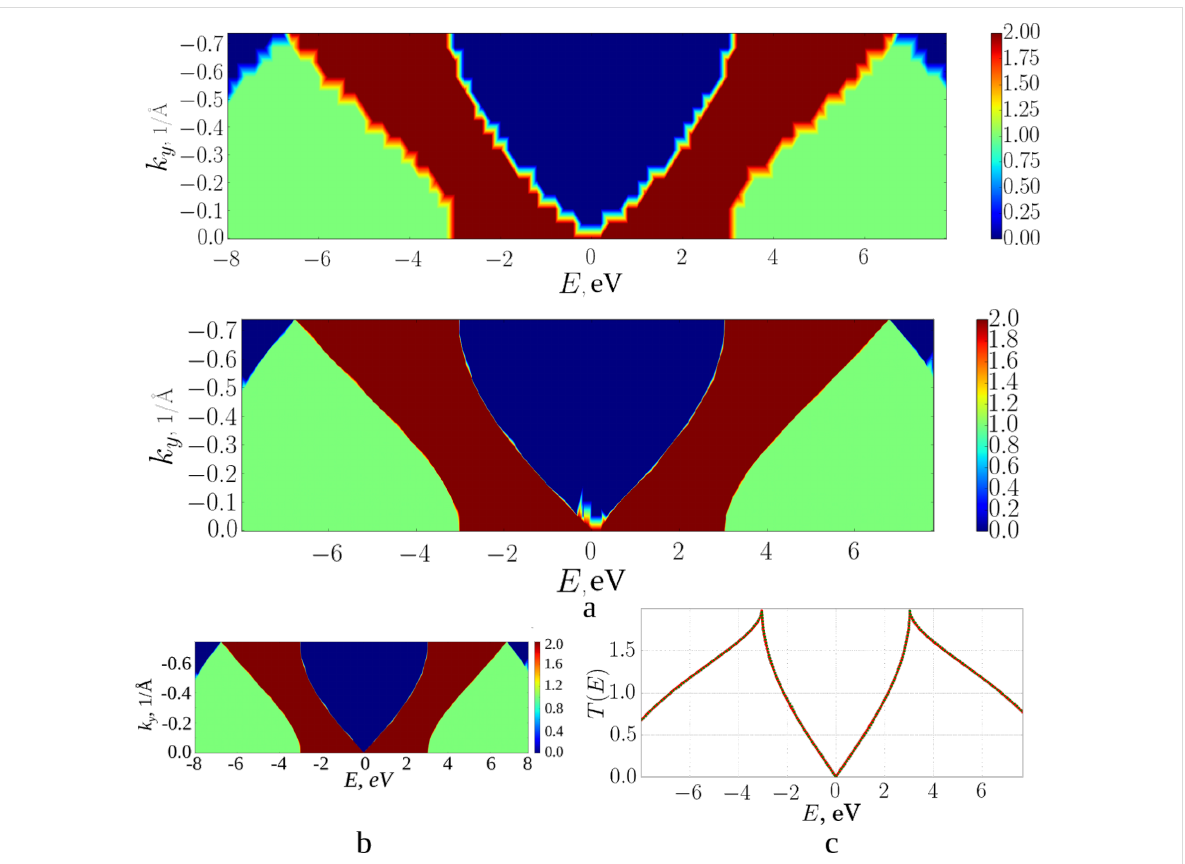
Figure 3: Graphene transmission function: a) a map of T ( E ) for the initial partitioning over k y (from above) and after applying the interpolating function Т 1 ( Е , k y ); b) a map of T ( E ) after applying the interpolating function Т 2 ( Е , k y ); c) averaged T ( E ) over all k y (green: interpolated, red: